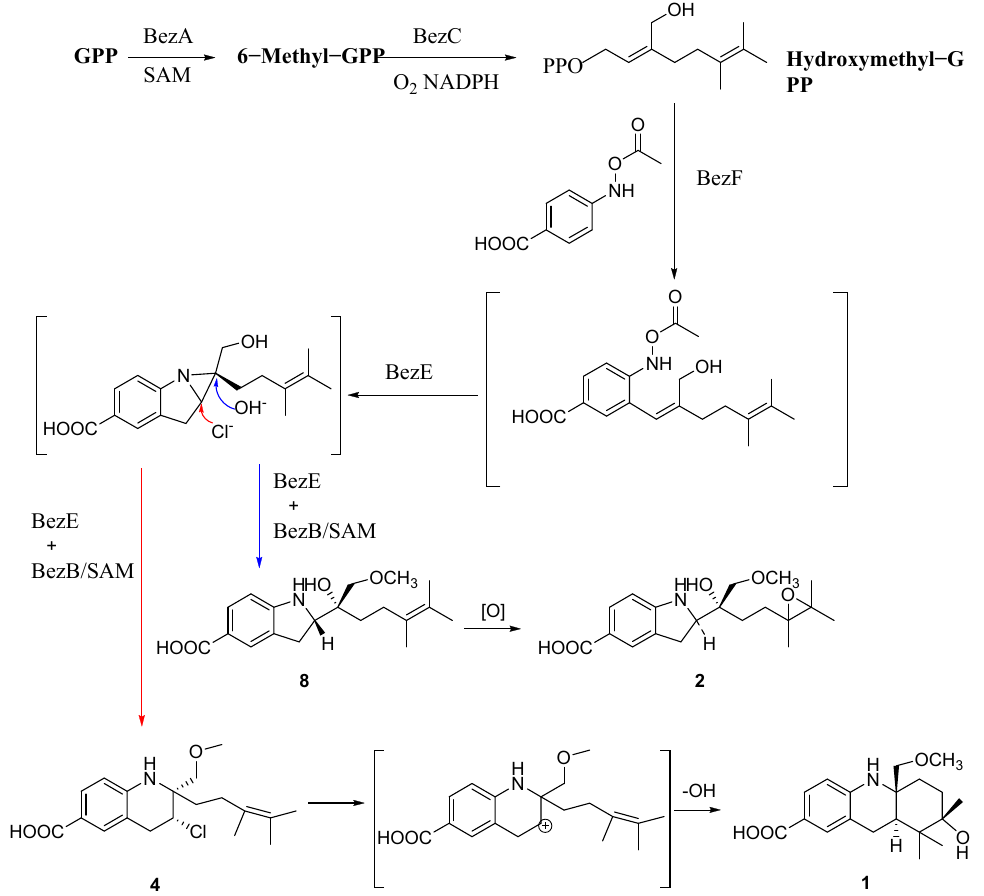
Figure 8. The probably biosynthetic process of compounds 1 and 2 . Virantmycin, which was first isolated from the fermentation broth of Streptomyces nitrosporeus , has been reported to show significant antiviral activity against various RNA and DNA viruses [19,26]. The antiviral activities of virantmycin derivatives indicate that the configurations of the tetrahydroquinoline ring unit, the carboxylic group, and the ter- minal tetrasubstituted double bond are responsible for the anti-influenza virus activity [19]. Benzastatin C, an amide derivative of virantmycin, has specific activities against sev- eral viruses, and benzastatin D, a hydroxyl substitute of benzastatin C, is inactive against the tested viruses, which suggests that chloride plays an important role as the active moi- ety for antiviral activity [27]. The present study (Table 1) also indicates that the chlorine atom is necessary for the antiviral activity. The good leaving groups (for example, chlorine or mesyl group) in the structure are shown to be essential to the activity, and the com- pound may react with the target protein through the substitution reaction [18]. Com- pound 4 has the best activity among the isolated compounds, which leads to the conclusion that the tetrahydroquinoline skeleton and the methyl group of the terminal double bond play an important role in the activation of anti-PRV activity. Benzastatin C and ben- zastatin D show mostly equal free radical scavenging activity, indicating that their anti- PRV activity is not related to antioxidant ability [28]. The mode of action of virantmycin